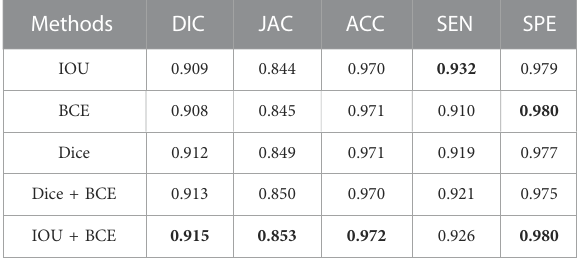
TABLE 4 Different loss functions in SL-HarDNet using the ISIC-2018 skin lesion